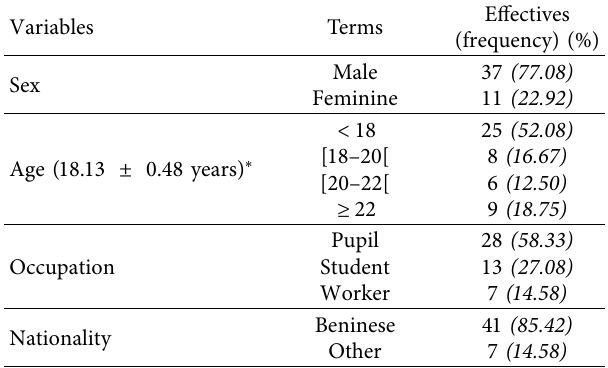
Table 2: Period of beginning of cannabis use.